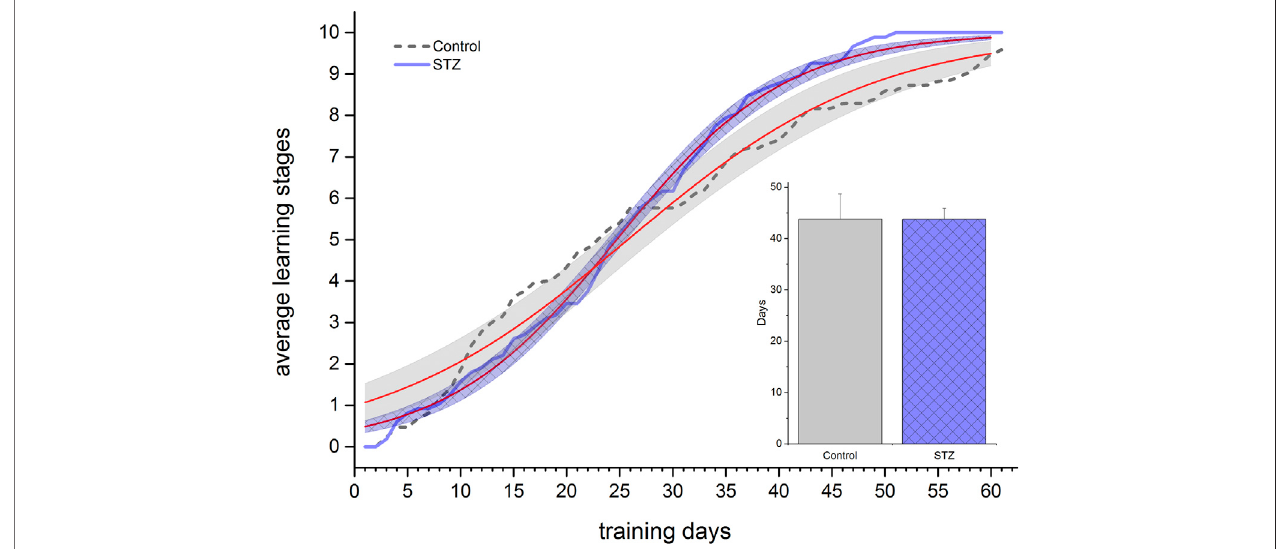
FIGURE 6 | Learning performance in the 5 Choice Reaction Time task in EXP1. Learning curves of control and STZ-treated animals are depicted. Shaded areas showthe95%con fi dencebandofthe fi ttedsigmoidalregressioncurves(thin[red] lines).Thecolumn chartinsetshowsthenumberofdaystakentoreachthemaximum stage. Means ± SEM values are shown. No signi fi cant difference was detected either between the learning curves or in the days elapsed until reaching the fi nal stage (unpaired t -test: t (15) (cid:2) 0.25, ns).